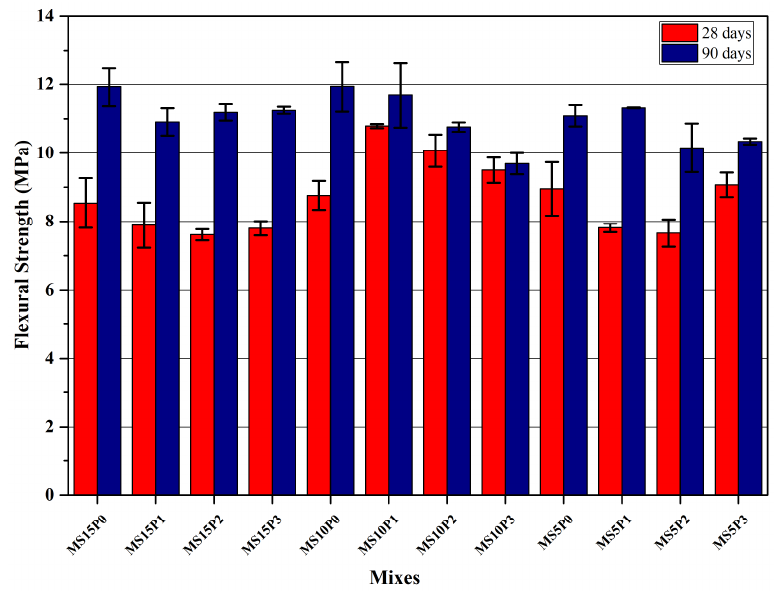
Figure 10. Flexural strength values of the MS samples .